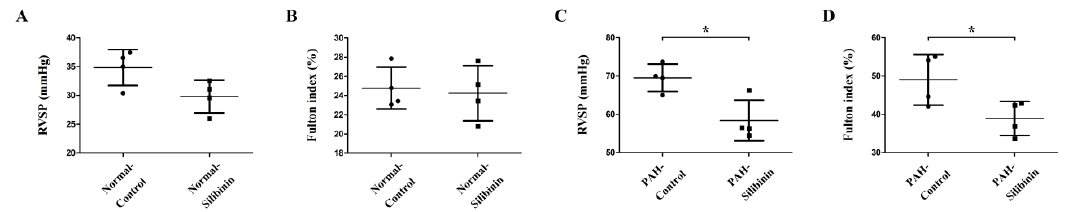
Figure 6. Hemodynamic studies of PAH without or with silibinin treatment. ( A , B ) Silibinin did not decrease RVSP ( A ) and the Fulton index ( B ) after two weeks of treatment in the normal-silibinin group compared to the normal-control group. ( C , D ) Silibinin significantly decreased RVSP ( C ) and the Fulton index ( D ) after two weeks of treatment in the PAH-silibinin group compared to the PAH-control group. * p < 0.05. Each group consisted of four rats.